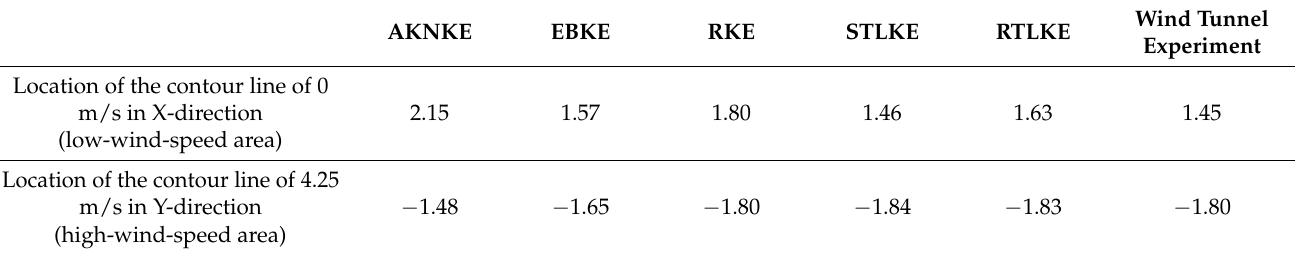
Figure 13. Contour plots of X-velocity ( U ) at z/b = 1.25. Table 8. Location of contour line at z/b = 1.25 ( U ).